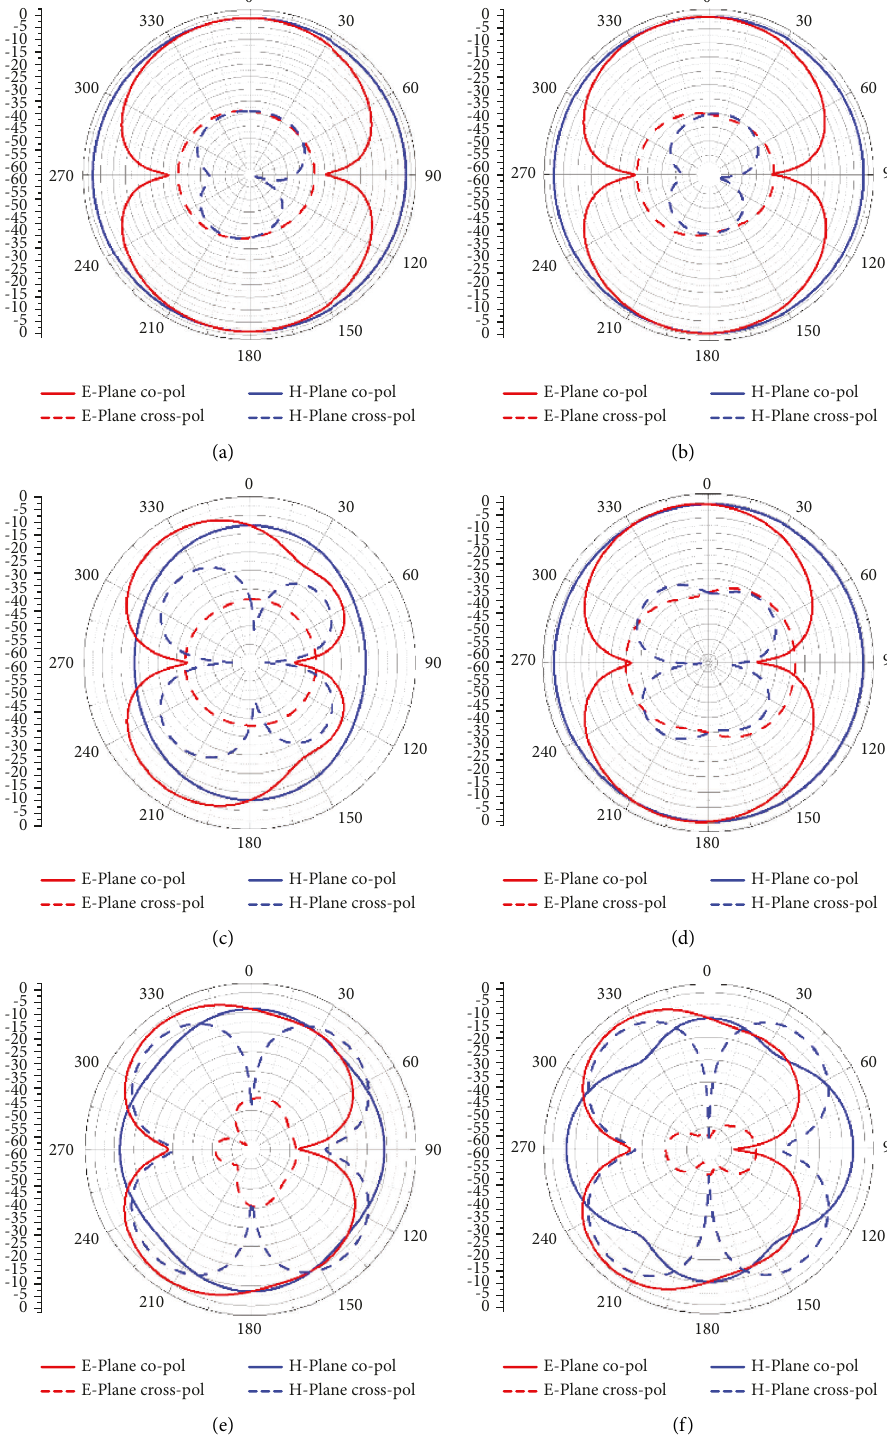
Figure 10: E- and H- plane radiation patterns at: (a) 2.25GHz, (b) 2.5GHz, (c) 3.1 GHz, (d) 3.55GHz, (e) 5.7GHz, and (f)